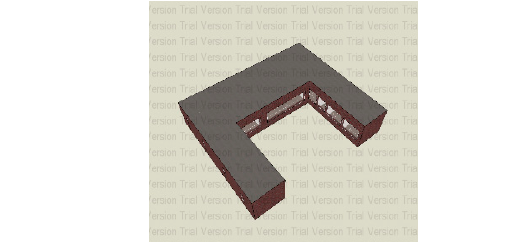
Energies 2020 , 13 , x FOR PEER REVIEW Figure 9. Plan and elevation of Rural House 2. Figure 9. Plan and elevation of Rural House 2. Figure 9. Plan and elevation of Rural House 2.